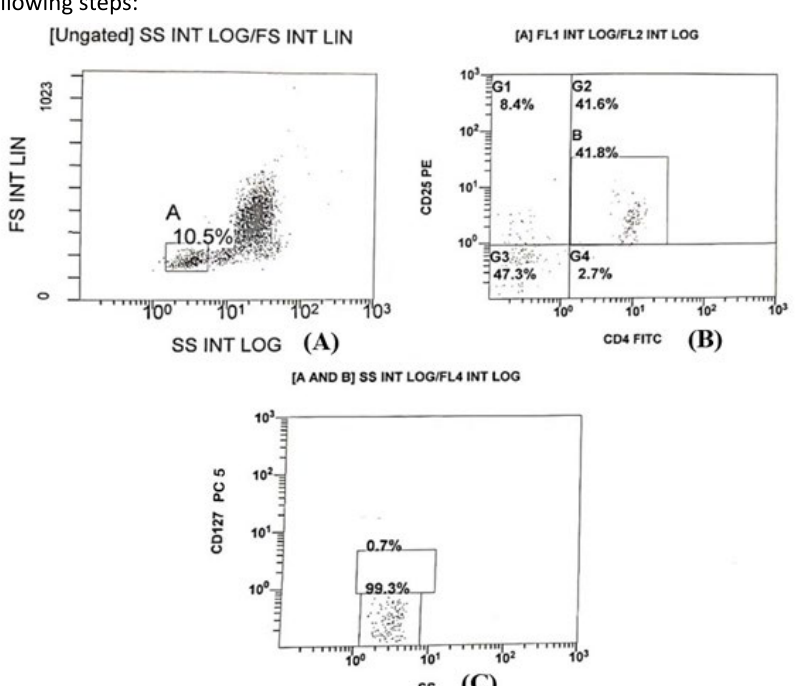
Fig.1. lymphocytes stained with anti-CD4 FITC, anti-CD25 PE and anti CD127 PC5: (A) dot blot of forward scatter (FS) versus SS (side scatter) shows lymphocytes gate A which represent 10.5 % of the harvested cell populations. (b) A dot plot of anti-CD25 PE versus anti-CD4 FITC shows that 41.8 % of the gated lymphocytes populations were CD4 + CD25 + , a gate G2 included this population. (c) CD4 + CD25 + lymphocytes were examined for expression of CD127. the dot blot demonstrates that 99.3% of the CD4 + CD25 + lymphocytes population did not express or fairly express CD127 So, activated T-regs percentage was 41.5% in this sample as T-regs were defined as CD4 + CD25 + CD127 dim/−